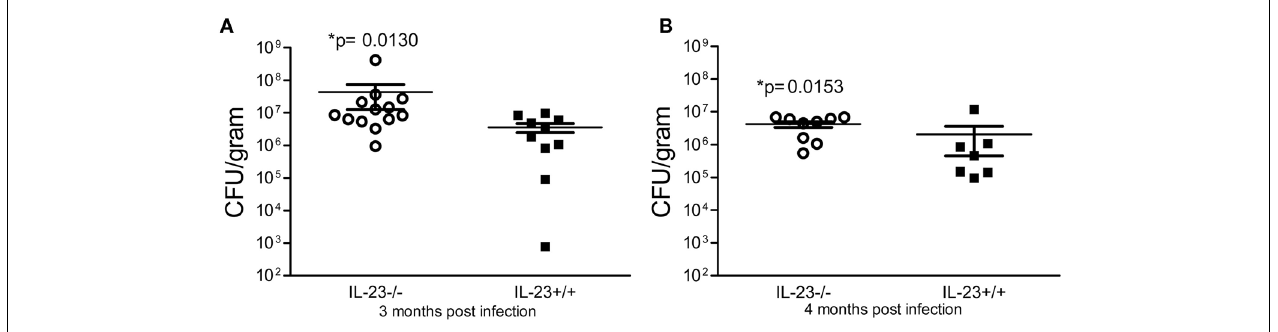
serial dilutions of stomach homogenates.The number of colony forming units (CFU) per gram of stomach tissue is presented on the graphs for 3months post-infection (A) and 4months post-infection (B)